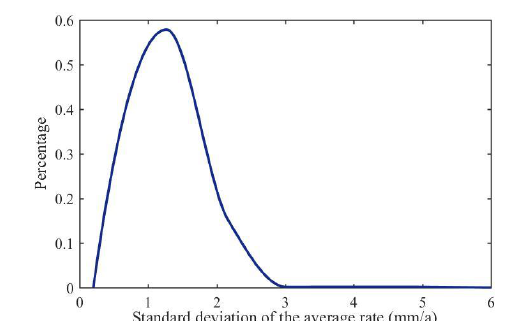
Figure 7. The probability density function of the standard